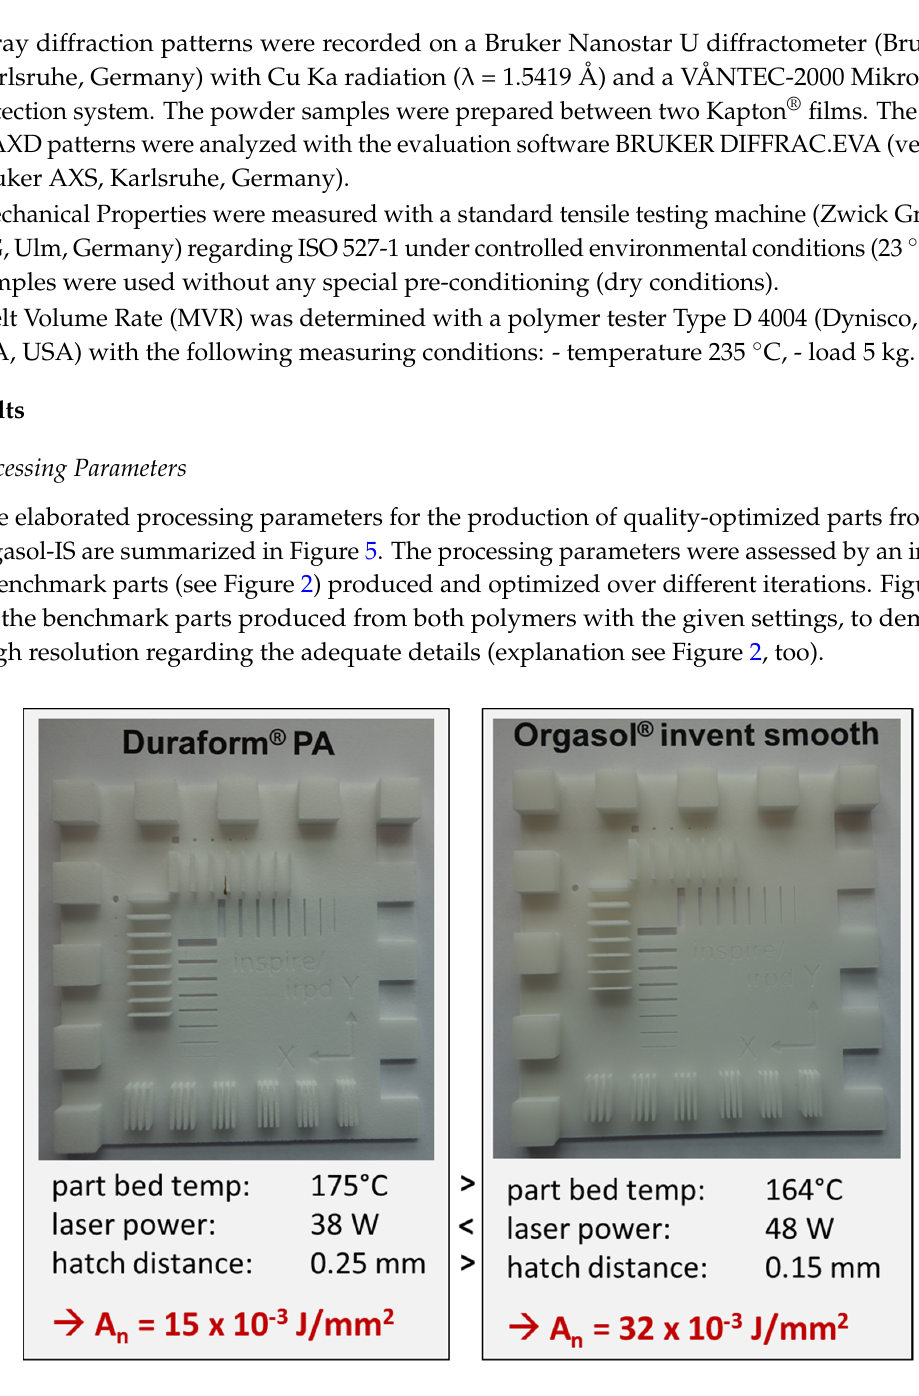
Figure 5. Comparison of processing parameters for the production of parts.